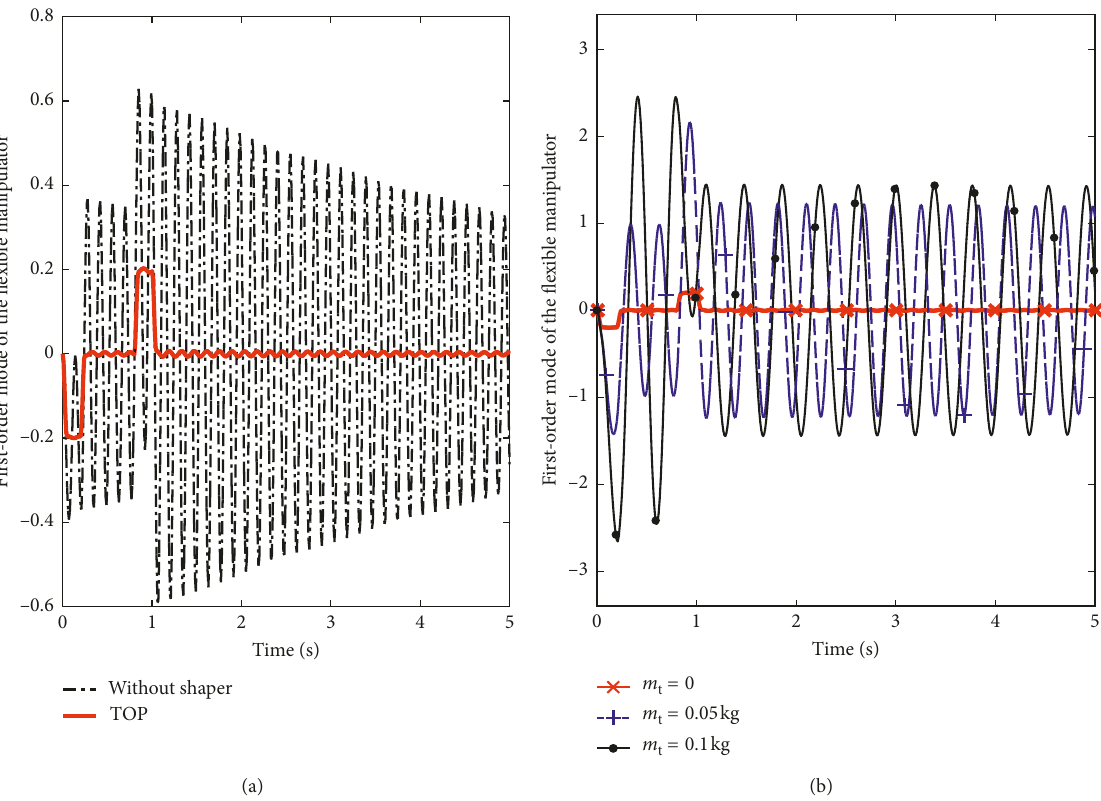
Figure 5: Control effect of the two-mode vibration cascade shaper on the elastic vibration of the flexible manipulator: (a) comparison of control effect before and after shaping; (b) control effect under different terminal loads.